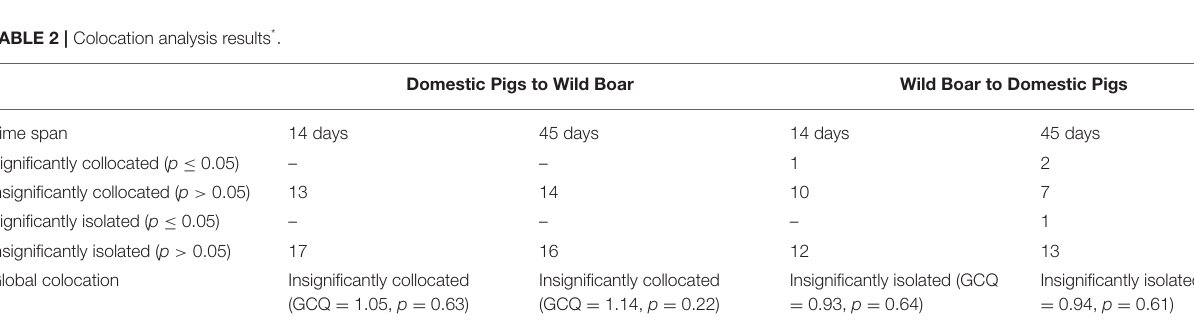
TABLE 2 | Colocation analysis results * . Domestic Pigs to Wild Boar Wild Boar to Domestic